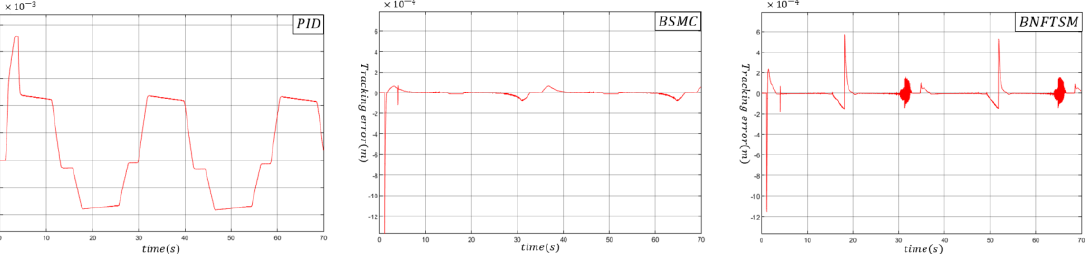
Figure 7. Tracking error curves of three controllers without load force: PID, BSMC, BNTFSM.